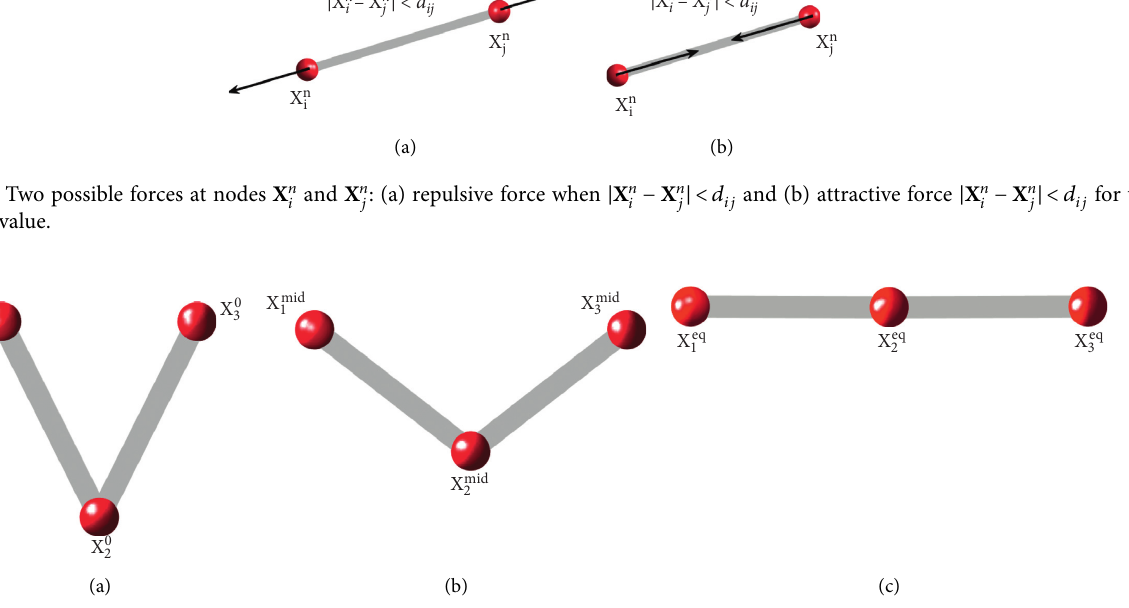
Figure 3: Mutual repulsive force among nodes: (a) initial state, (b) middle state, and (c) equilibrium state.